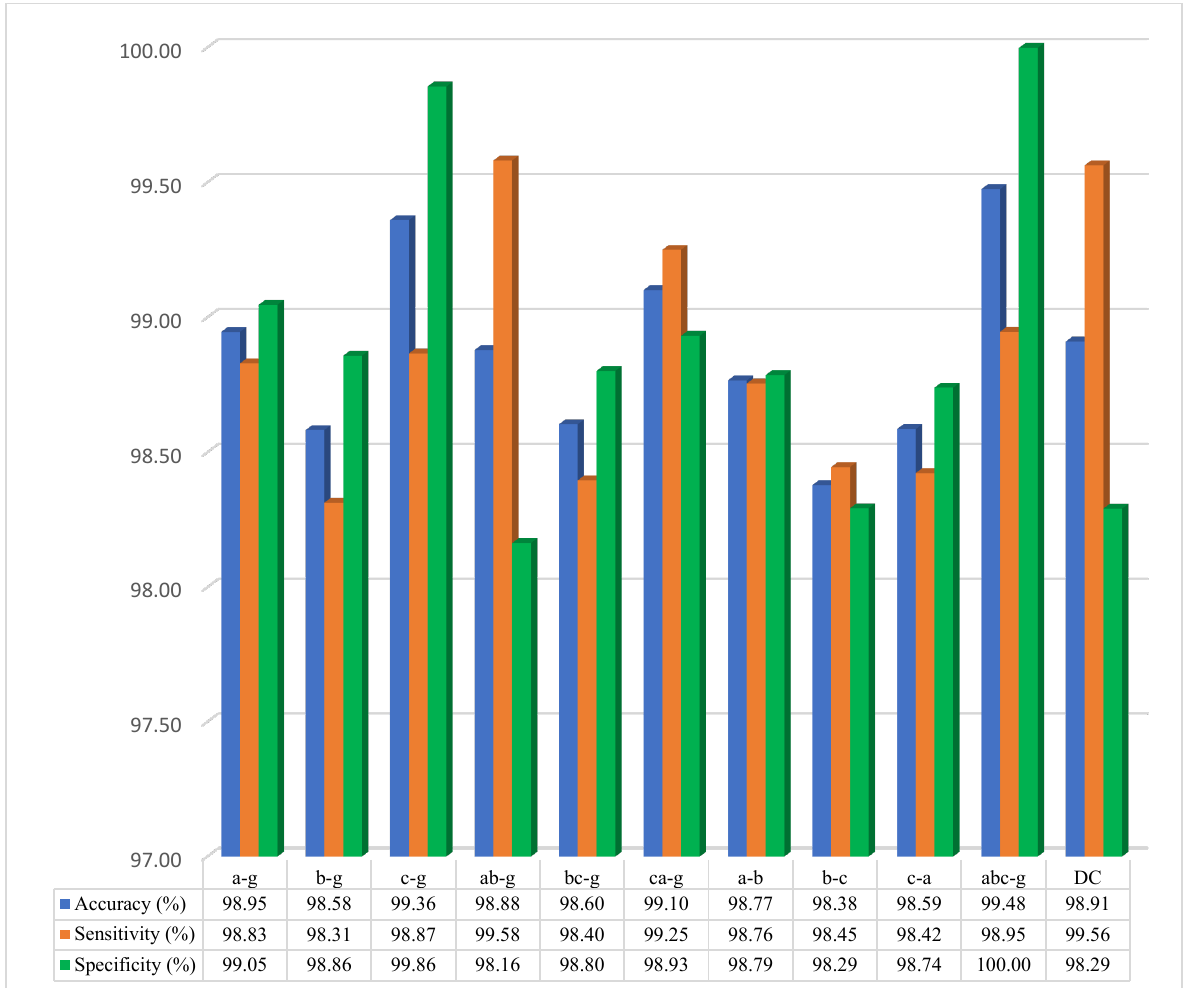
Figure 8. Graphical chart illustration.